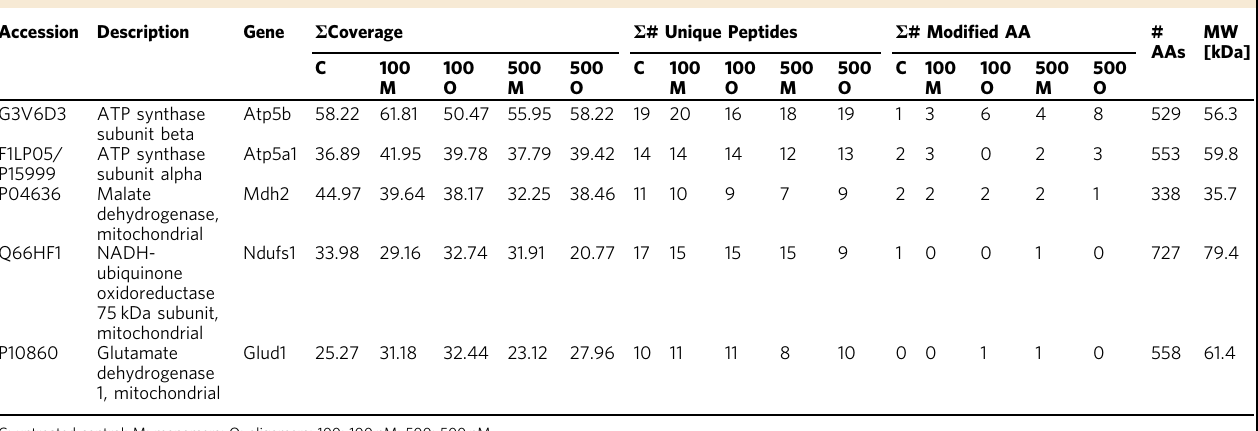
Table 2 Oxidation of amino acids by treatment with α -synuclein Accession